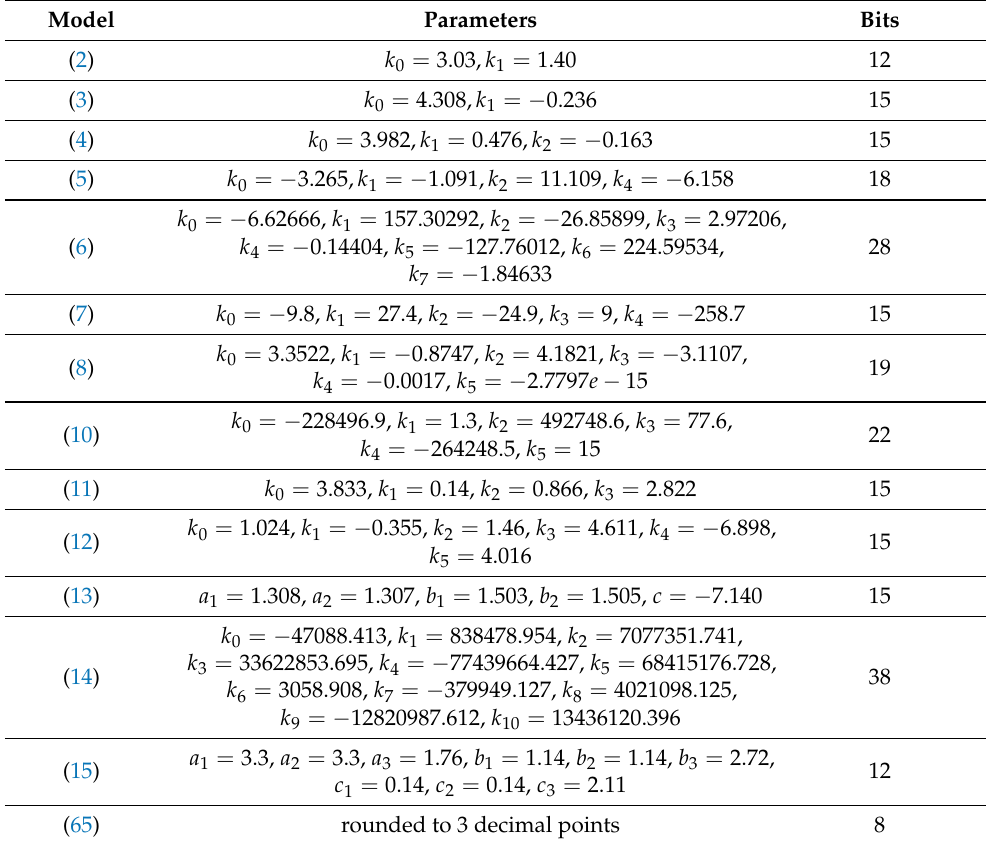
Figure 8. The effect of rounding in the tabular model is shown. Table 8. System requirements for OCV